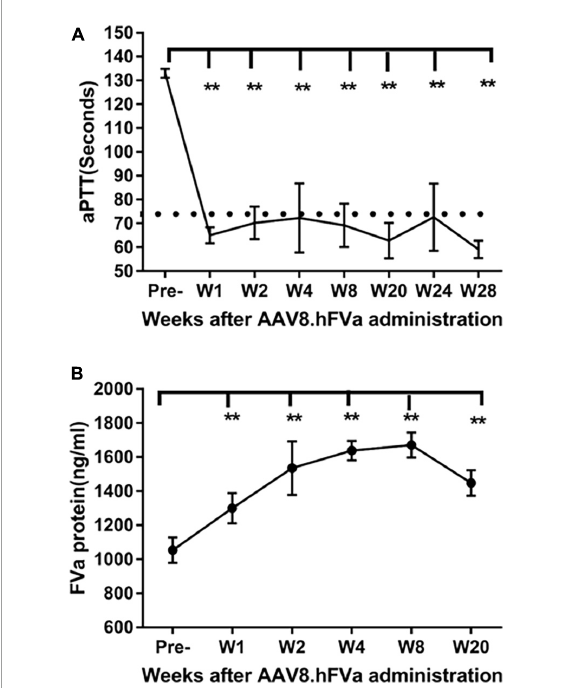
FIGURE3 Complete phenotypic correction after administration